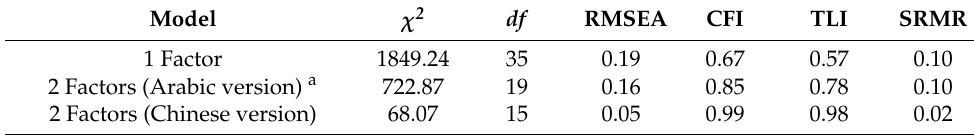
Table 2. Comparison of fit indices for three FoMO scales factor